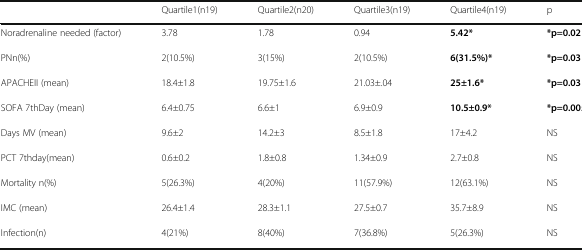
Table 1 (abstract 0105). See text for